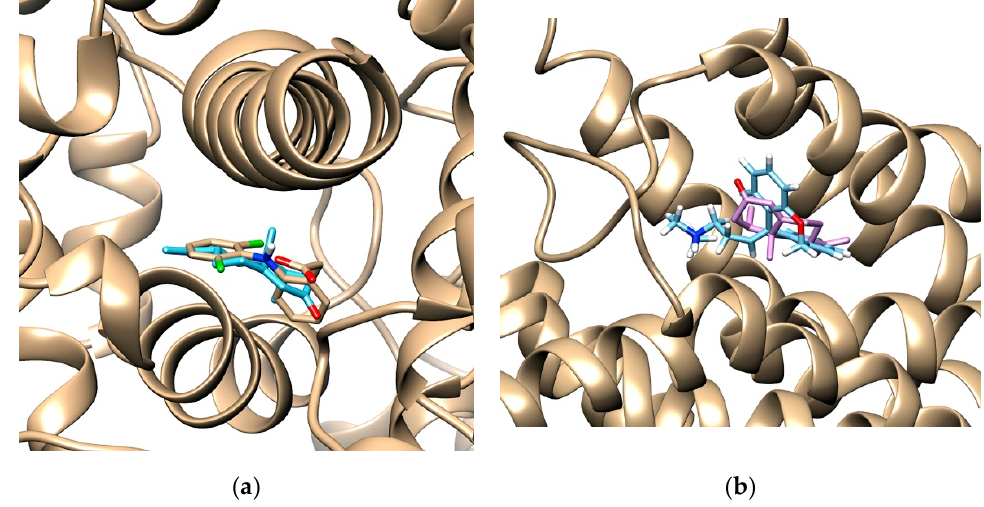
Figure 6. The binding poses of best stability between NTK and diclofenac into the cyclooxygenase (COX)-2 enzyme binding site ( a ) and between NTK and doxepin into the binding site of the H 1 receptor ( b ).